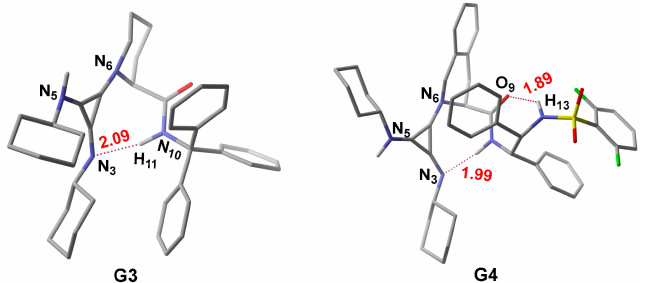
Figure 9. Optimized geometries of catalysts G3 and G4. The distances are in Å. The H atoms in phenyl and cyclohexyl groups are omitted for clarity.